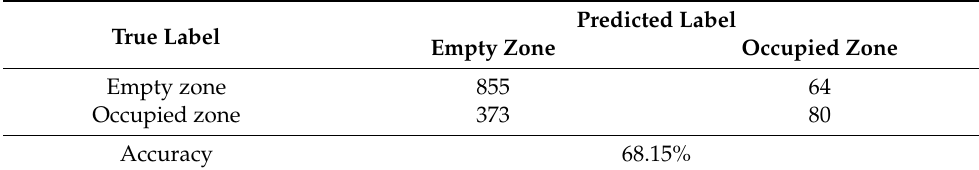
Table 3. Confusion matrix for the linear prediction model.